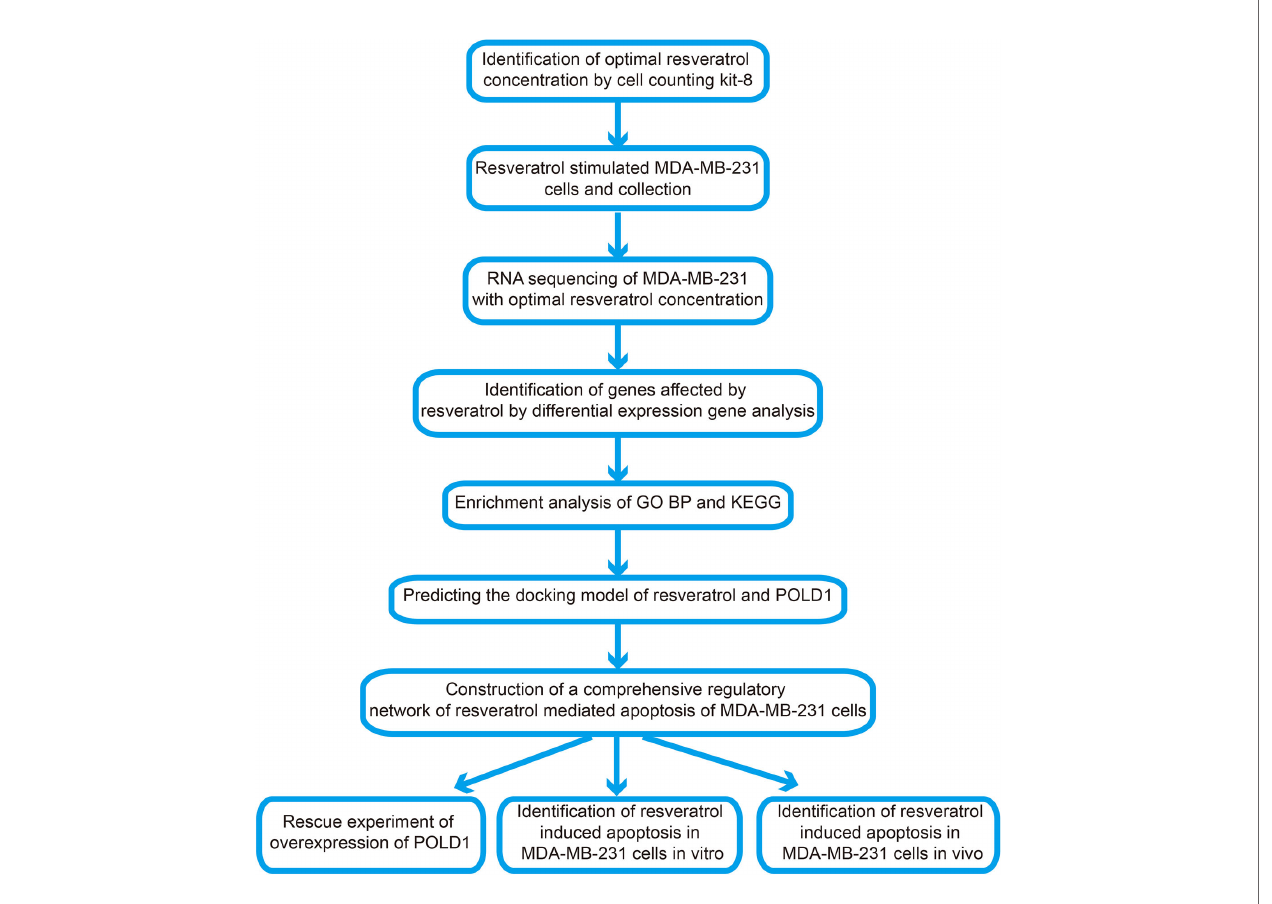
FIGURE 1 | Flow chart of present